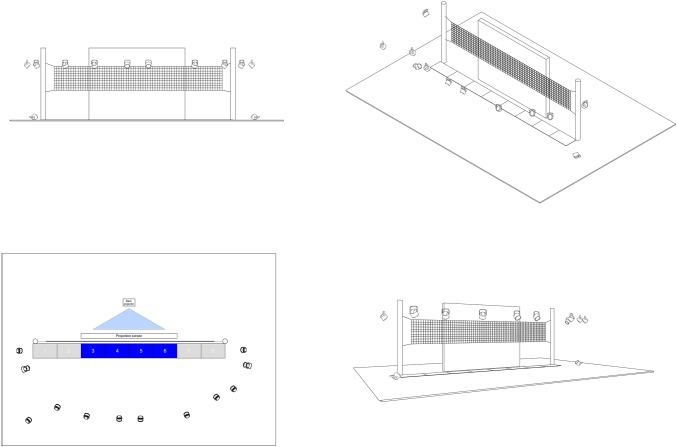
Experimental setup of the far-transfer task (adapted from Fleddermann and Zentgraf, 2018, p. 4).